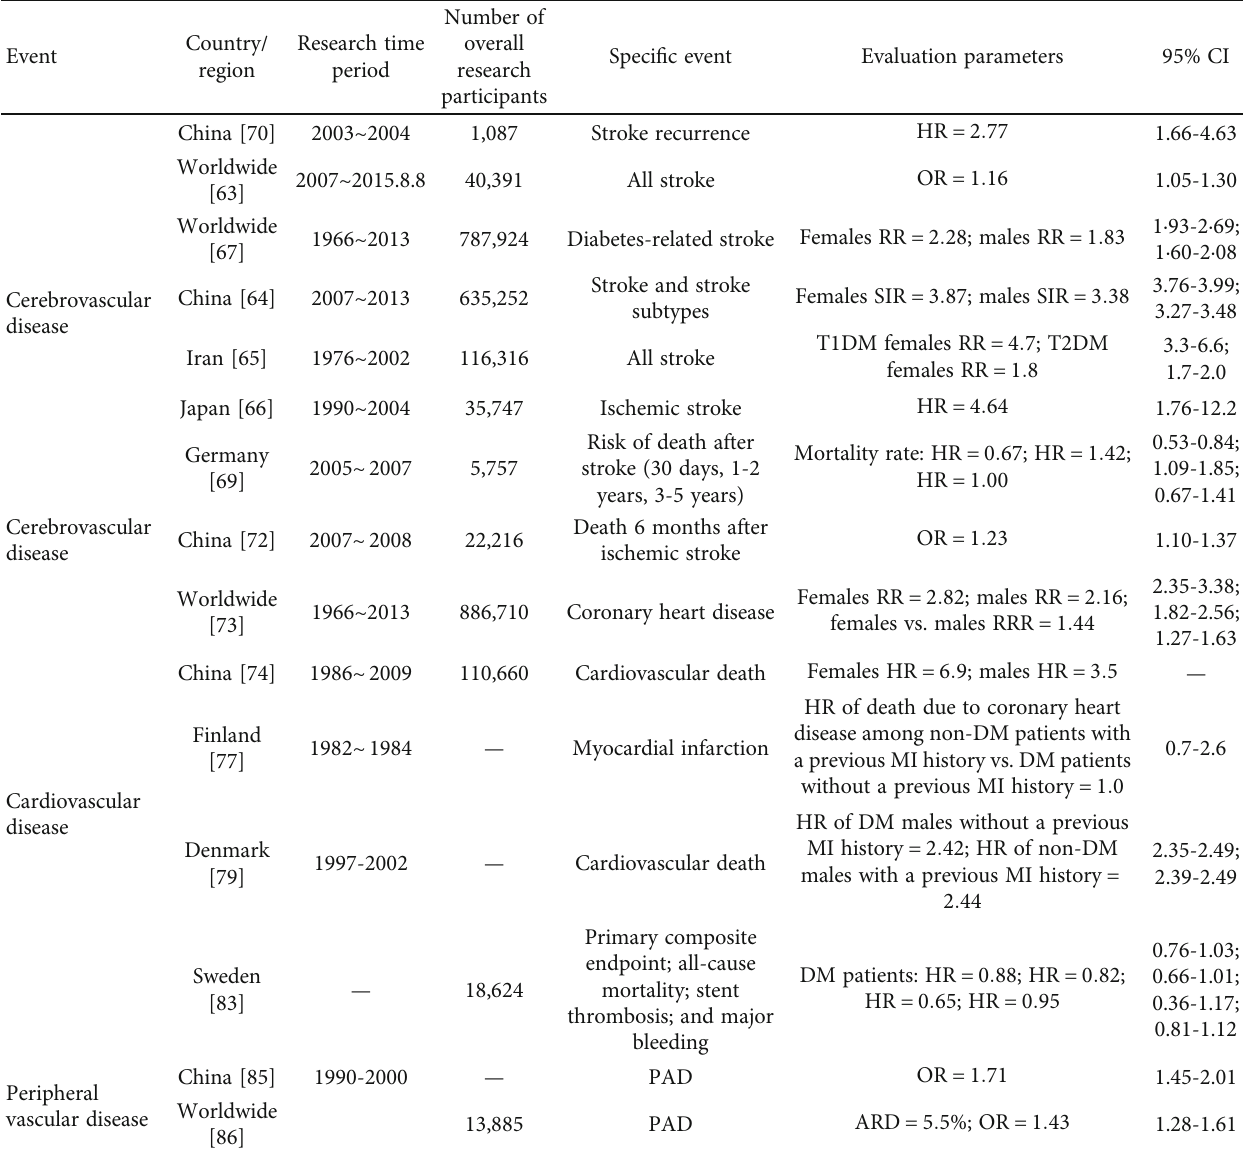
Table 1: Comparison of the risk of di ff erent diabetic vascular